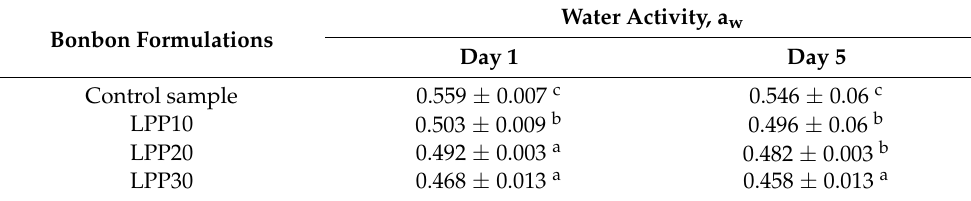
Table 7. Water activity (a w ) of bonbon